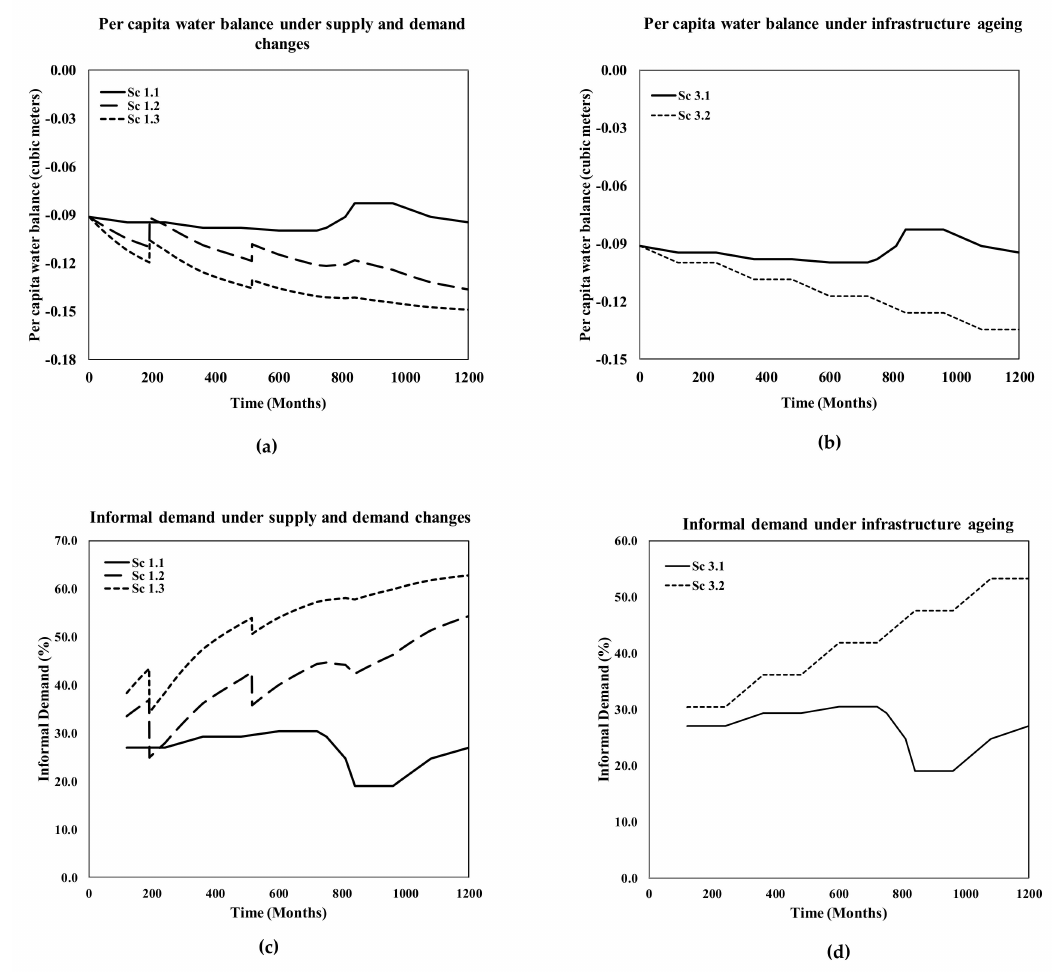
Figure 5. Sensitivity analysis results for ( a ) Per capita water balance under supply–demand changes, ( b ) per capita water balance under infrastructure ageing, ( c ) HH demand shift to informal under supply–demand changes, and ( d ) demand shift under infrastructure